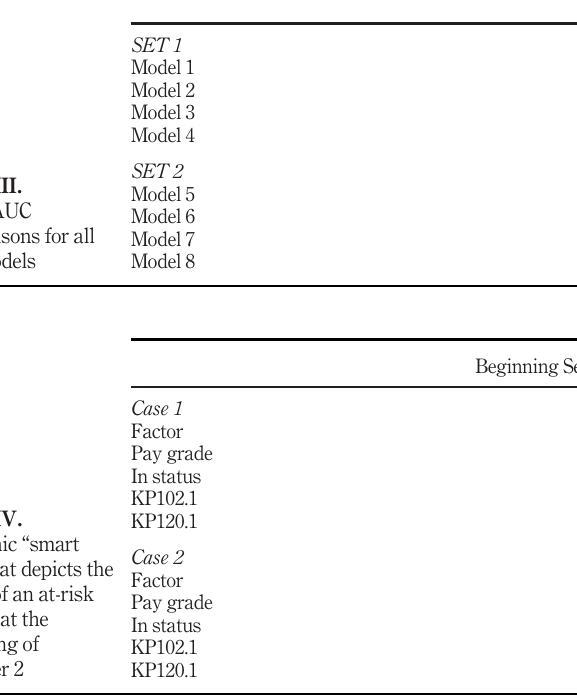
card ” that depicts the pro fi le of an at-risk student at the beginning of Semester 2